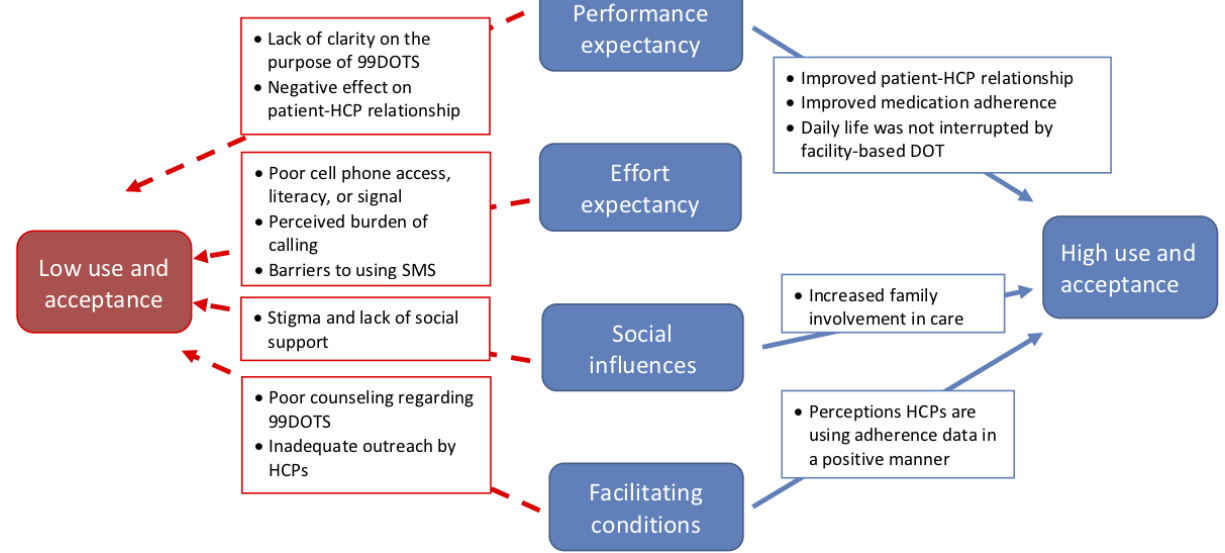
Figure 1. Key findings regarding the determinants of high and low acceptance and use of 99DOTS by patients with tuberculosis, based on the framework of the Unified Theory of Acceptance and Use of Technology. Note that there is no arrow between effort expectancy and high use and